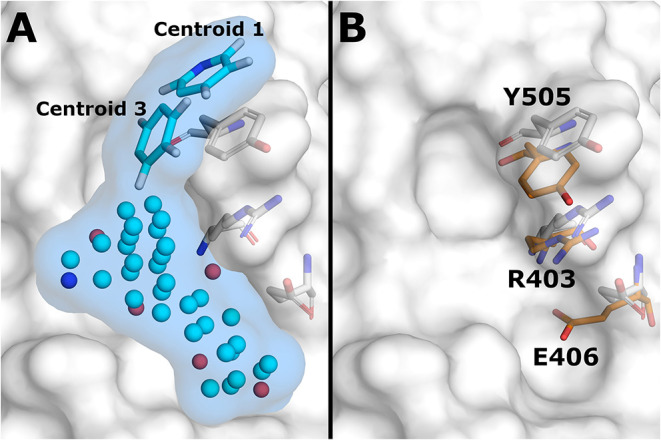
Docking conformation of ACE2 binding interface of RBD. (A) NIB-model (light blue surface) used in rescoring of docking results. Model atoms are shown as cyan (neutral), blue (positively charged), and red (negatively charged) spheres. Centroid probes included in the model are shown as sticks (C = cyan, N = blue, H = white). (B) Comparison of three ACE2 interface amino acid conformations between crystal structure (sticks, orange C atoms) and energy minimized MD simulation structure (sticks, white C atoms) of RBD. Simulation structure of RBD related to the probe centroid 3 is shown as white surface representation in both figures.